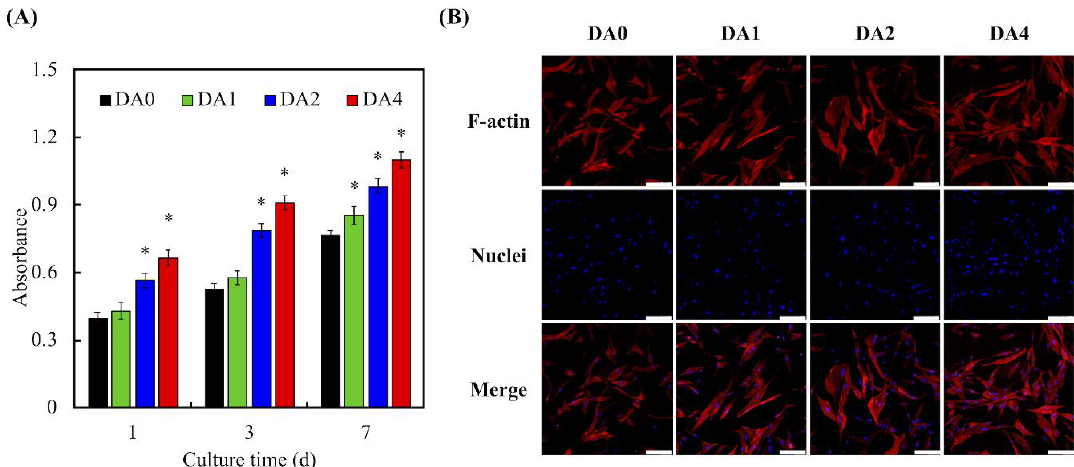
Figure 9. ( A ) PrestoBlue and ( B ) F-actin staining of WJMSC cultured with various specimens for different time points. “*” indicates a significant difference ( p < 0.05) compared to DA0. The scale bar = 100 µm.